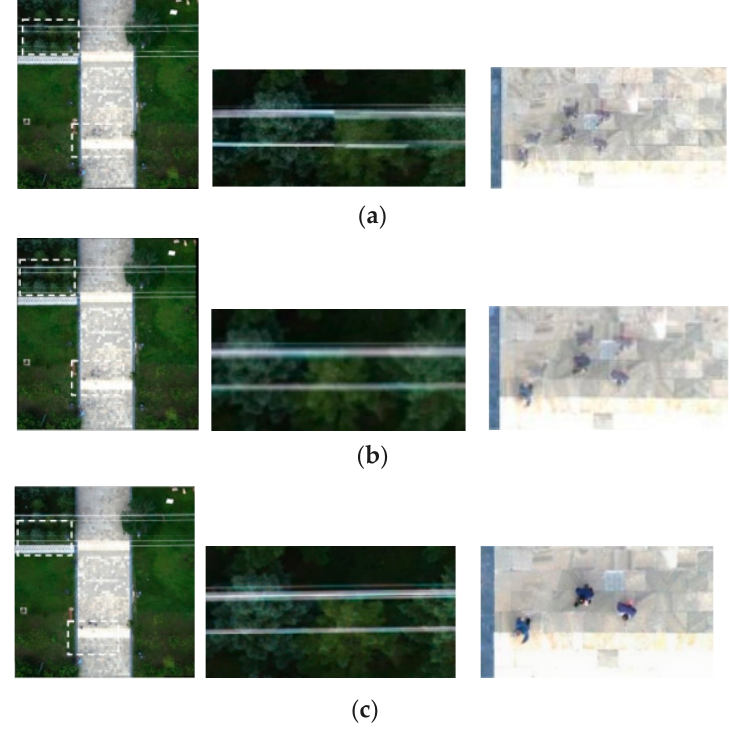
Figure 3. Comparison of Image Mosaic Results. ( a – c ) show stitching results of the APAP, AANAP, and ours separately. ( a ) Stitching result of the APAP; ( b ) Stitching result of the AANAP; ( c ) Stitching result of Ours (Two areas of each result are enlarged in the figure).